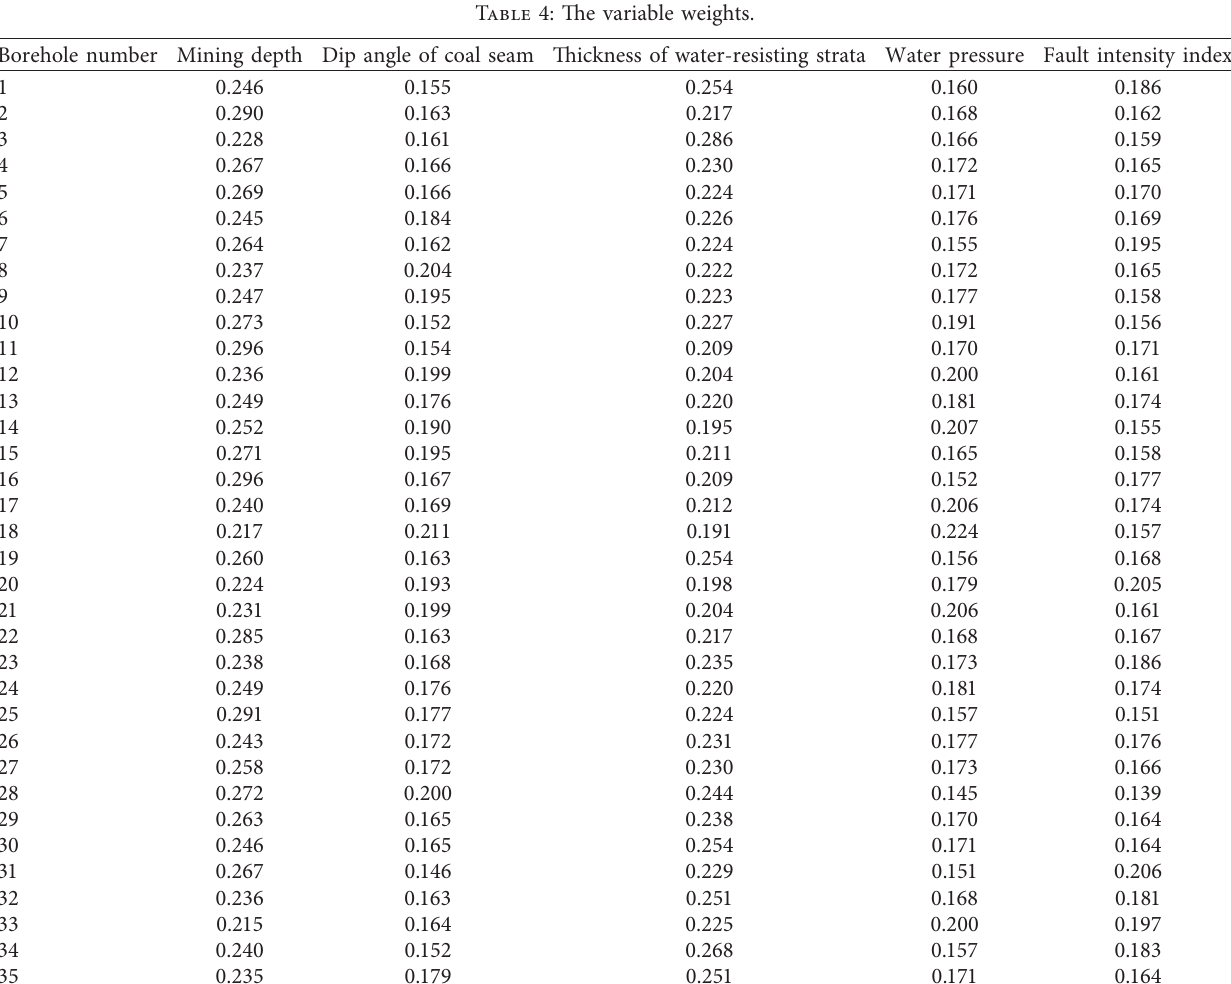
Table 4: The variable